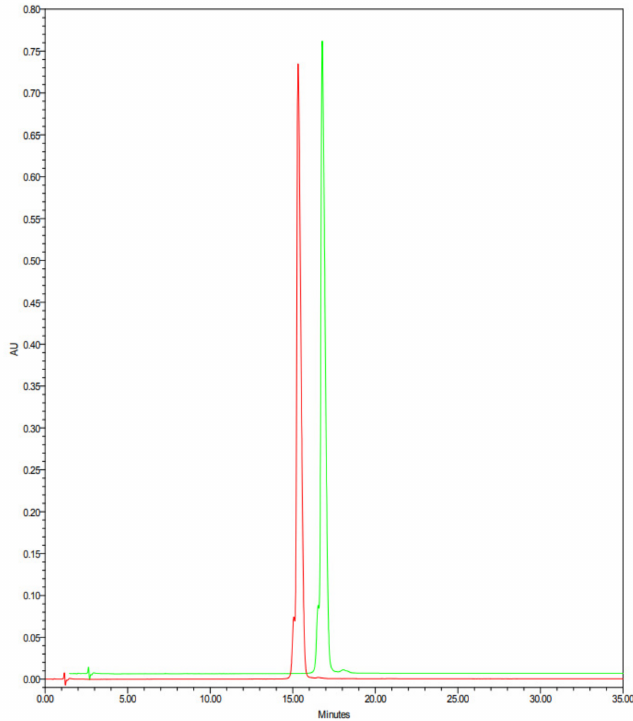
Figure 5. HPLC chromatograms of native lysozyme HCl (red line) and heat-treated lysozyme HCl (green